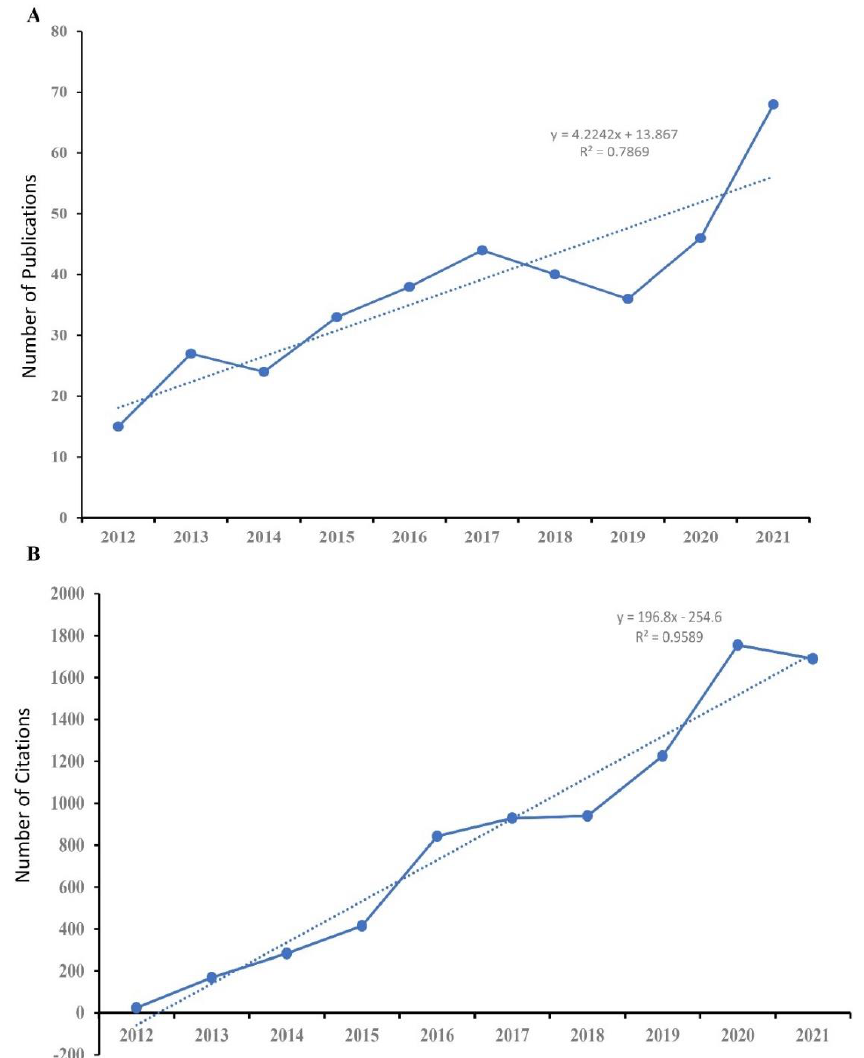
Figure 2. The number of annual publications ( A ) and the sum of annual citations ( B ) in studies of tDCS in stroke from 2012 to 2021.